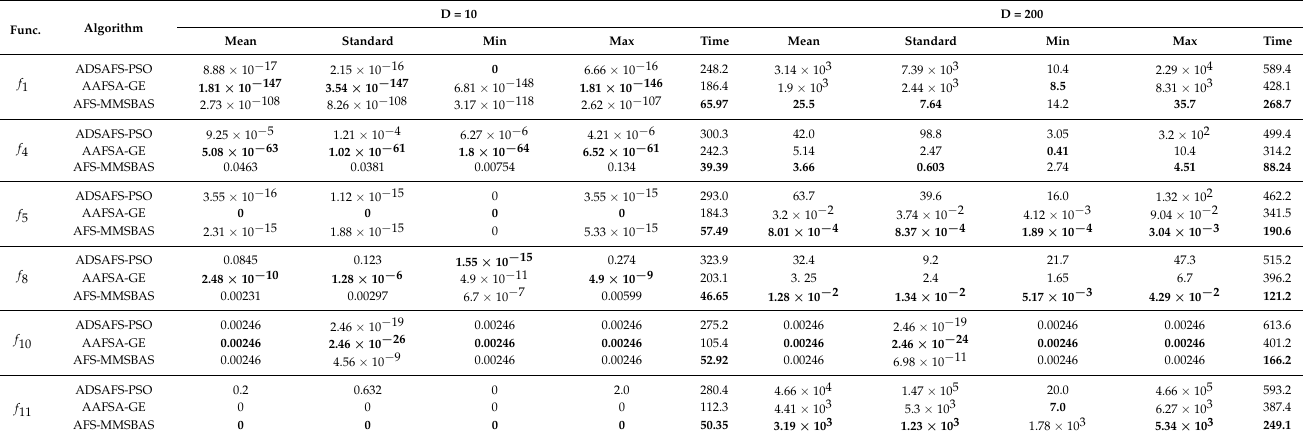
Table 6. Comparison between AFS-MMSBAS algorithm and other similar